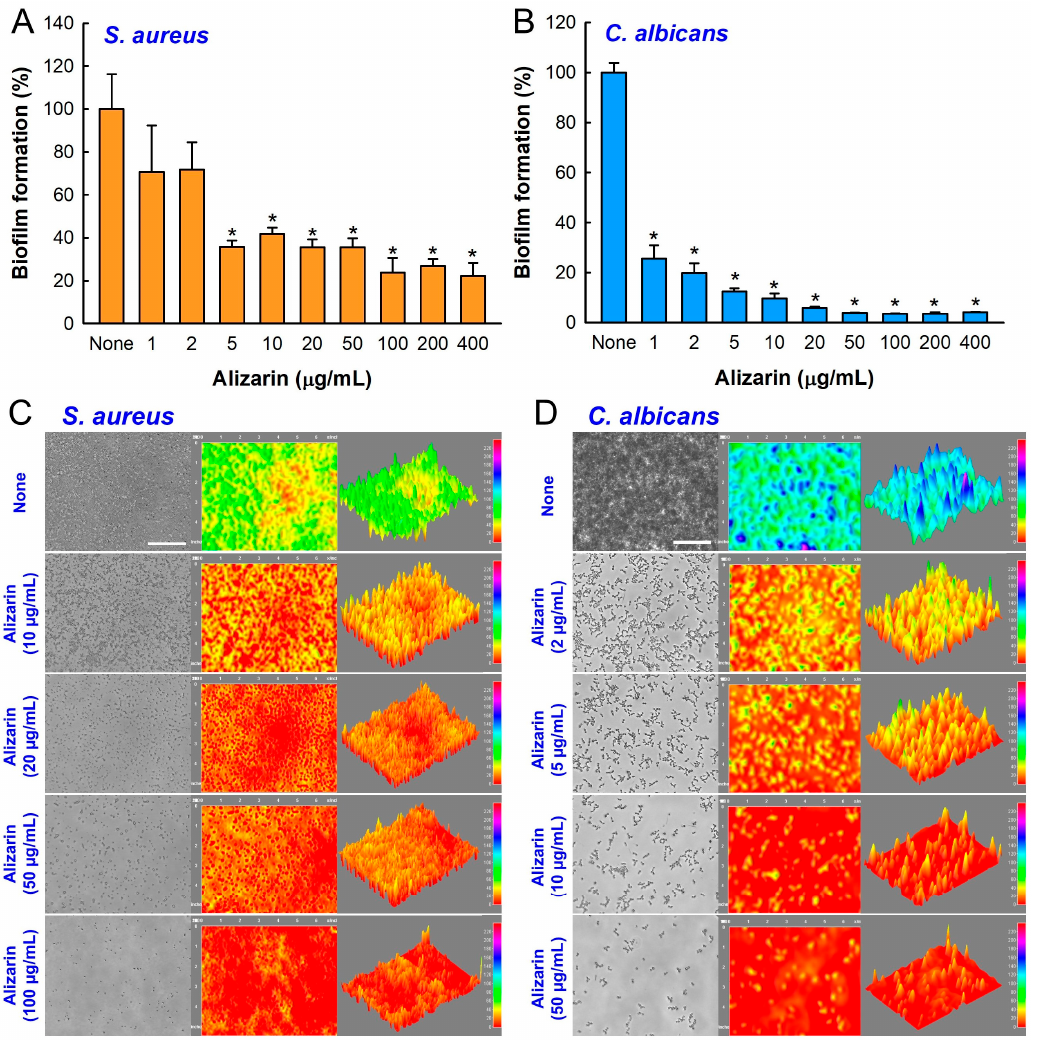
Figure 2. Inhibitory effect of alizarin on the biofilm development by S. aureus and C. albicans under anaerobic conditions. Biofilm developments by S. aureus ( A ) and C. albicans ( B ) were assessed after incubation for 7 days in 96-well plates under anaerobic conditions. Error bars represent standard deviations. * p < 0.05 vs. non-treated controls (None). Color-coded 2D and 3D images of biofilms after culturing S. aureus ( C ) or C. albicans ( D ) in the presence of alizarin for 7 days. White scale bars represent 100 µm.